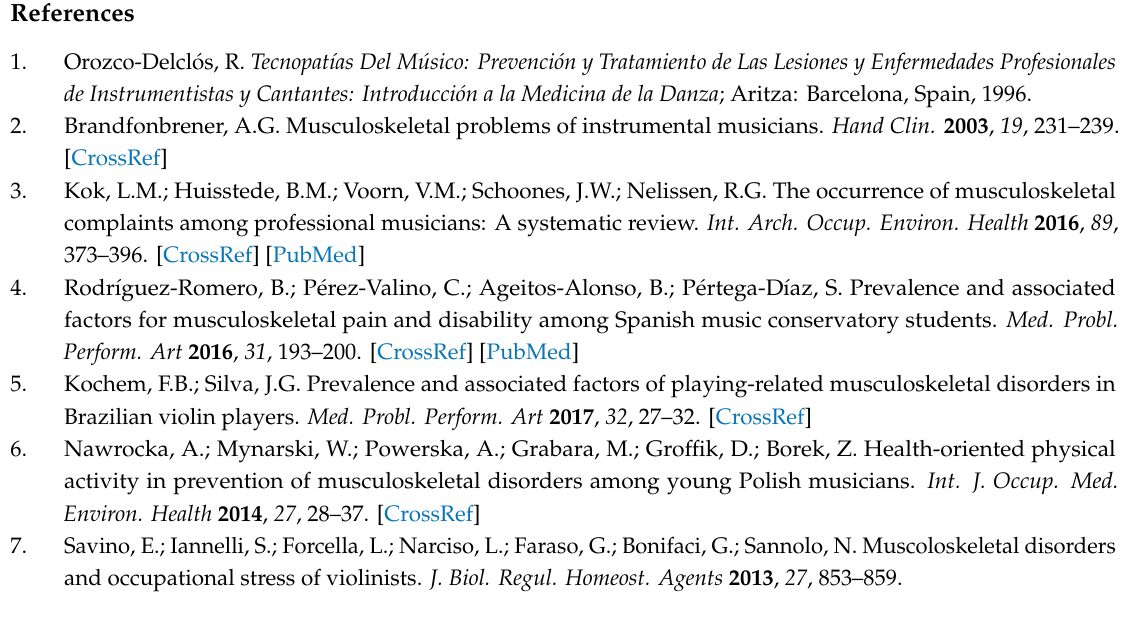
Table S1: The SNQ Spanish